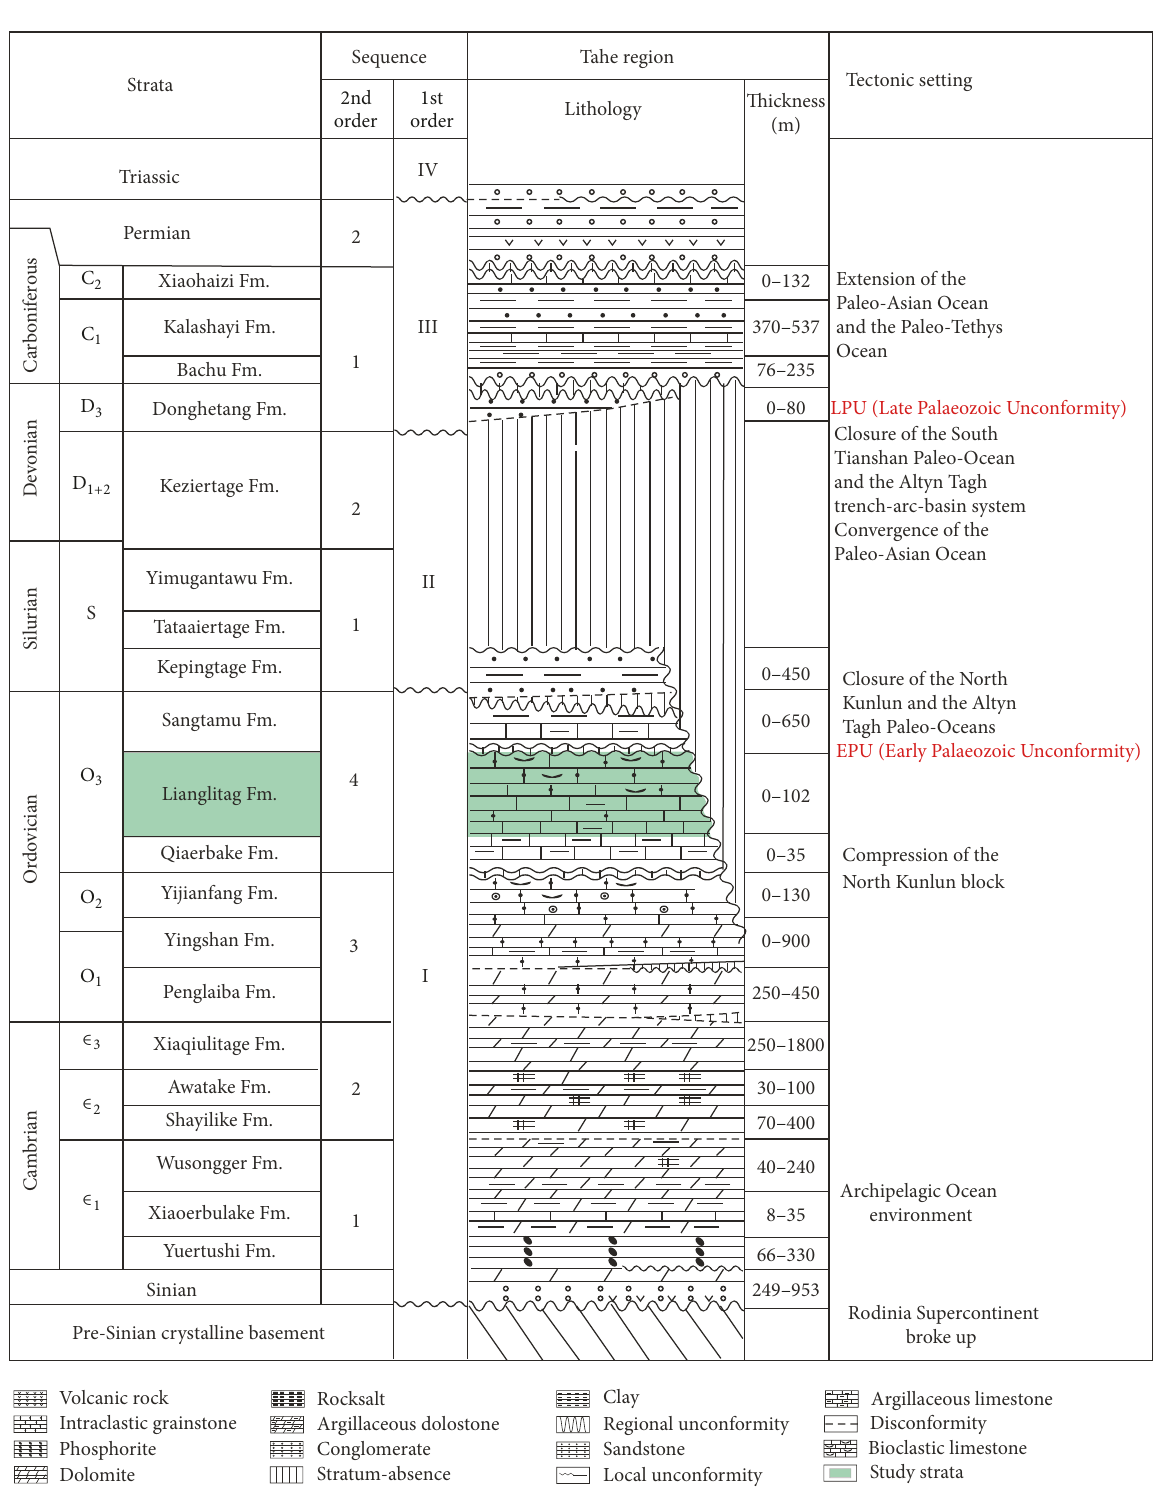
Figure 2: Stratigraphic chart showing the formations and hiatuses, modified after Lin et al.